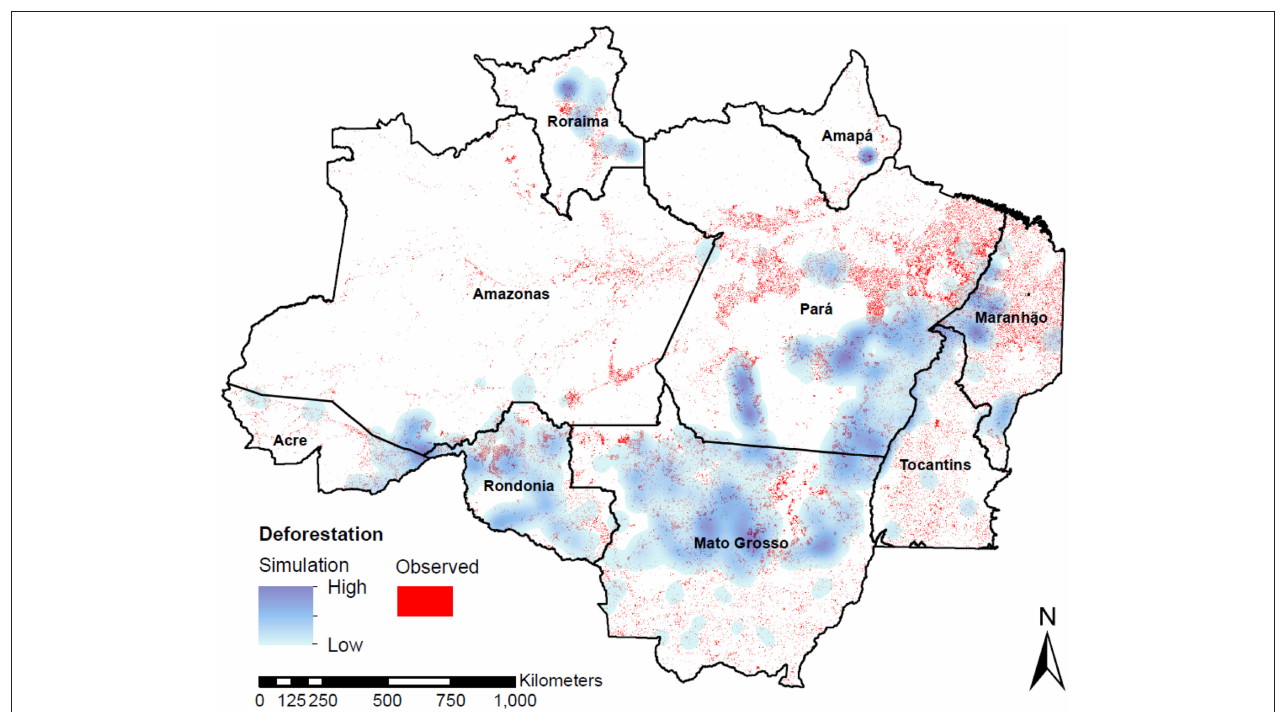
FIGURE 4 | Comparison between the spatialized 2006–2017 deforestation baseline (simulation) and the observed 2006–2017 deforestation (red patches). Simulated baseline displayed as deforestation hotspots (Kernel density) for improved visualization.